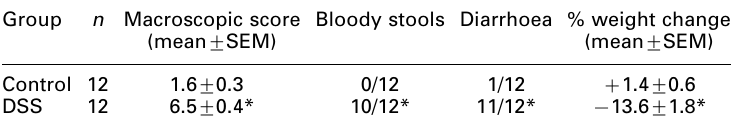
Table 1. Macroscopic degree of inflammation in DSS-induced colitis in mice Group